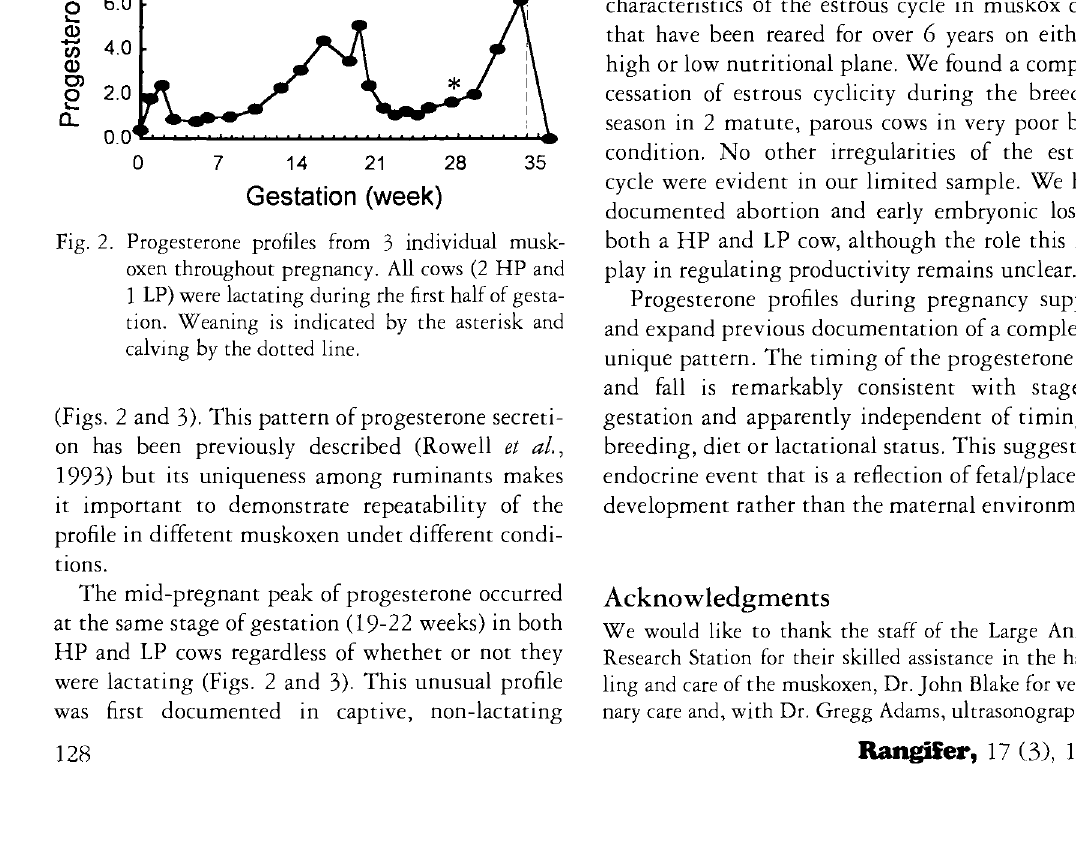
Fig. 3- Individual progesterone profiles throughout pregnancy from 3 non-lactating muskoxen (1 HP and 2